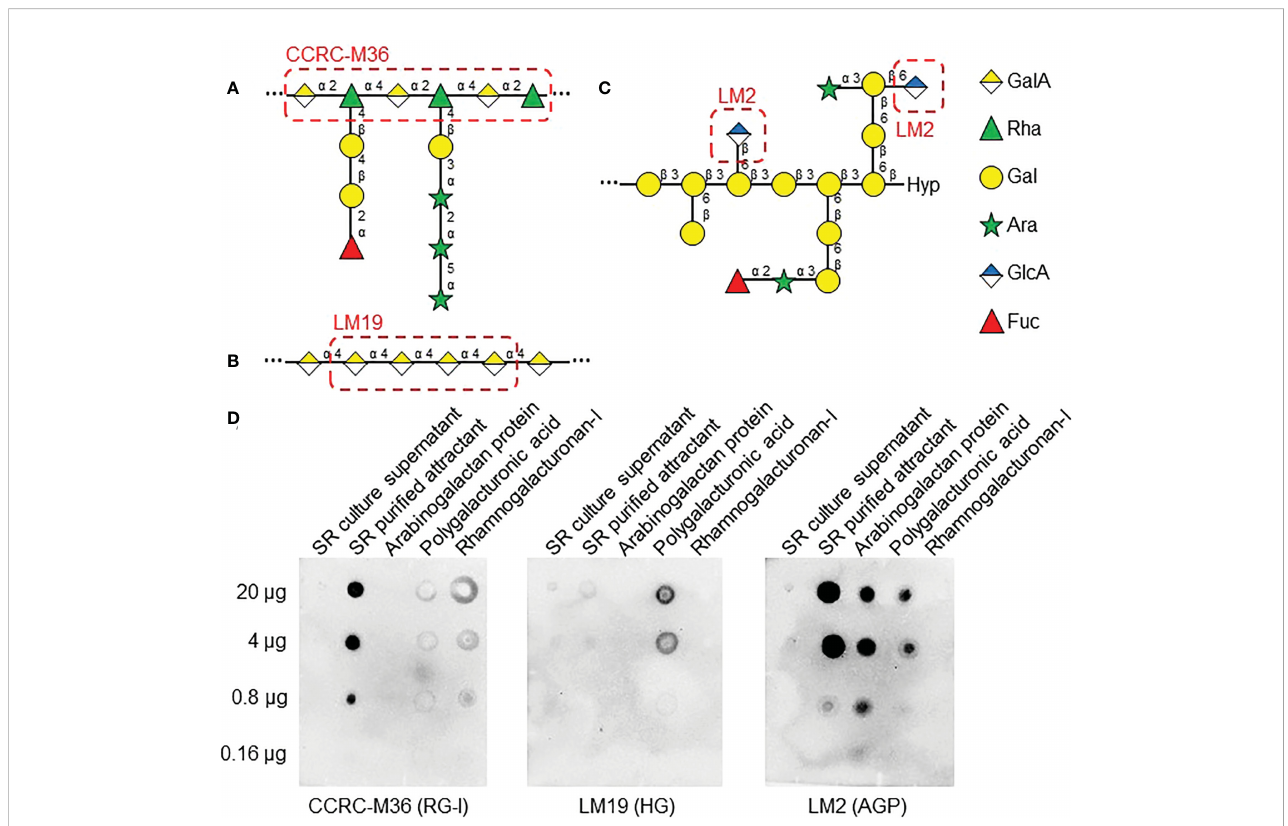
FIGURE 6 AGP and RG-I epitopes are present in RKN attractants from SR exudates. (A – C) Cell wall polysaccharide structures from Figure 4, with epitopes of antibodies used in (D) highlighted in red dashed boxes. RG-I -GalA- a (1,2)-Rha- a (1,4)- backbone is recognized by CCRC-M36 (A) , HG a (1,4)-linked GalA backbone is recognized by LM19 (B) , and b -linked GlcA of class II AG is recognized by LM2 (C) . (D) Immuno-blotting analysis of SR culture supernatant and SR puri fi ed RKN attractant, along with puri fi ed radish AGP, polygalacturonic acid, and RG-I as positive controls. 5-fold serial dilutions, starting with 20 µg of carbohydrates, were used as substrates. Samples were probed with LM2 (anti-AGP, left panel), LM19 (anti-HG, middle panel), and CCRC-M36 (anti-RG-I, right panel)